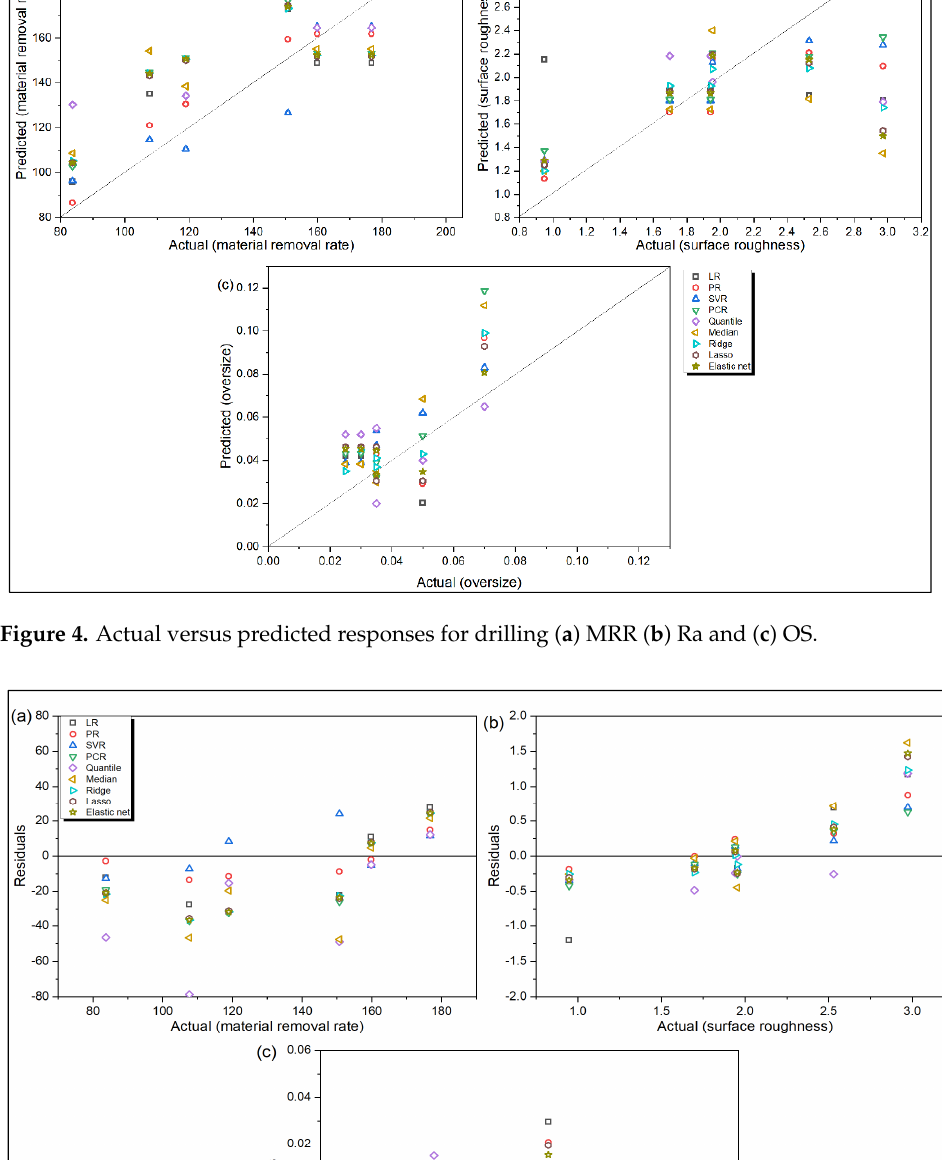
Figure 6. Predictive performance of various regression models for drilling operation. Prediction errors in terms of ( a ) MAPE ( b ) RMSPE ( c ) RMSLE ( d ) RRSE Table 9. Calculated p -values of Wilcoxon test for MRR in drilling. Model